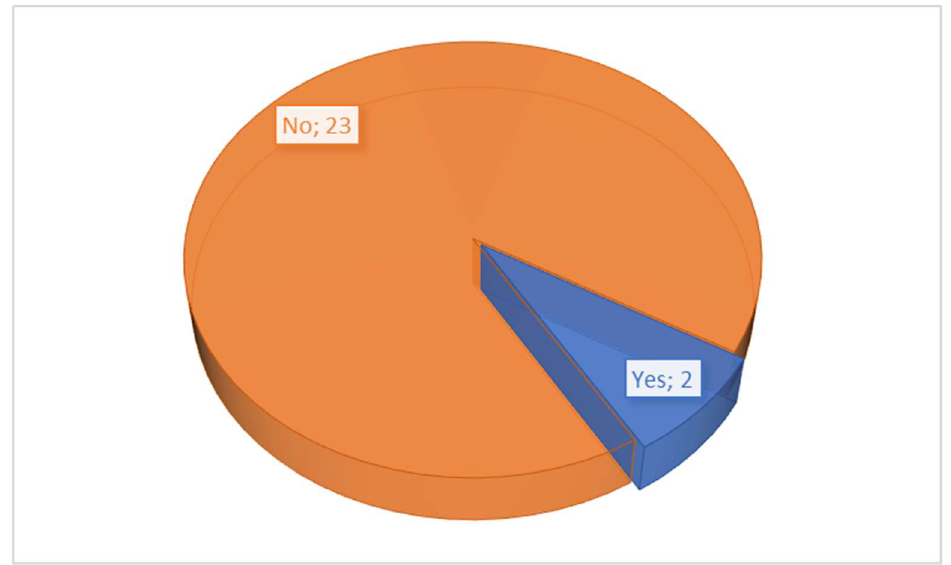
Figure 9. Collaboration with competitors in the shared mobility market.